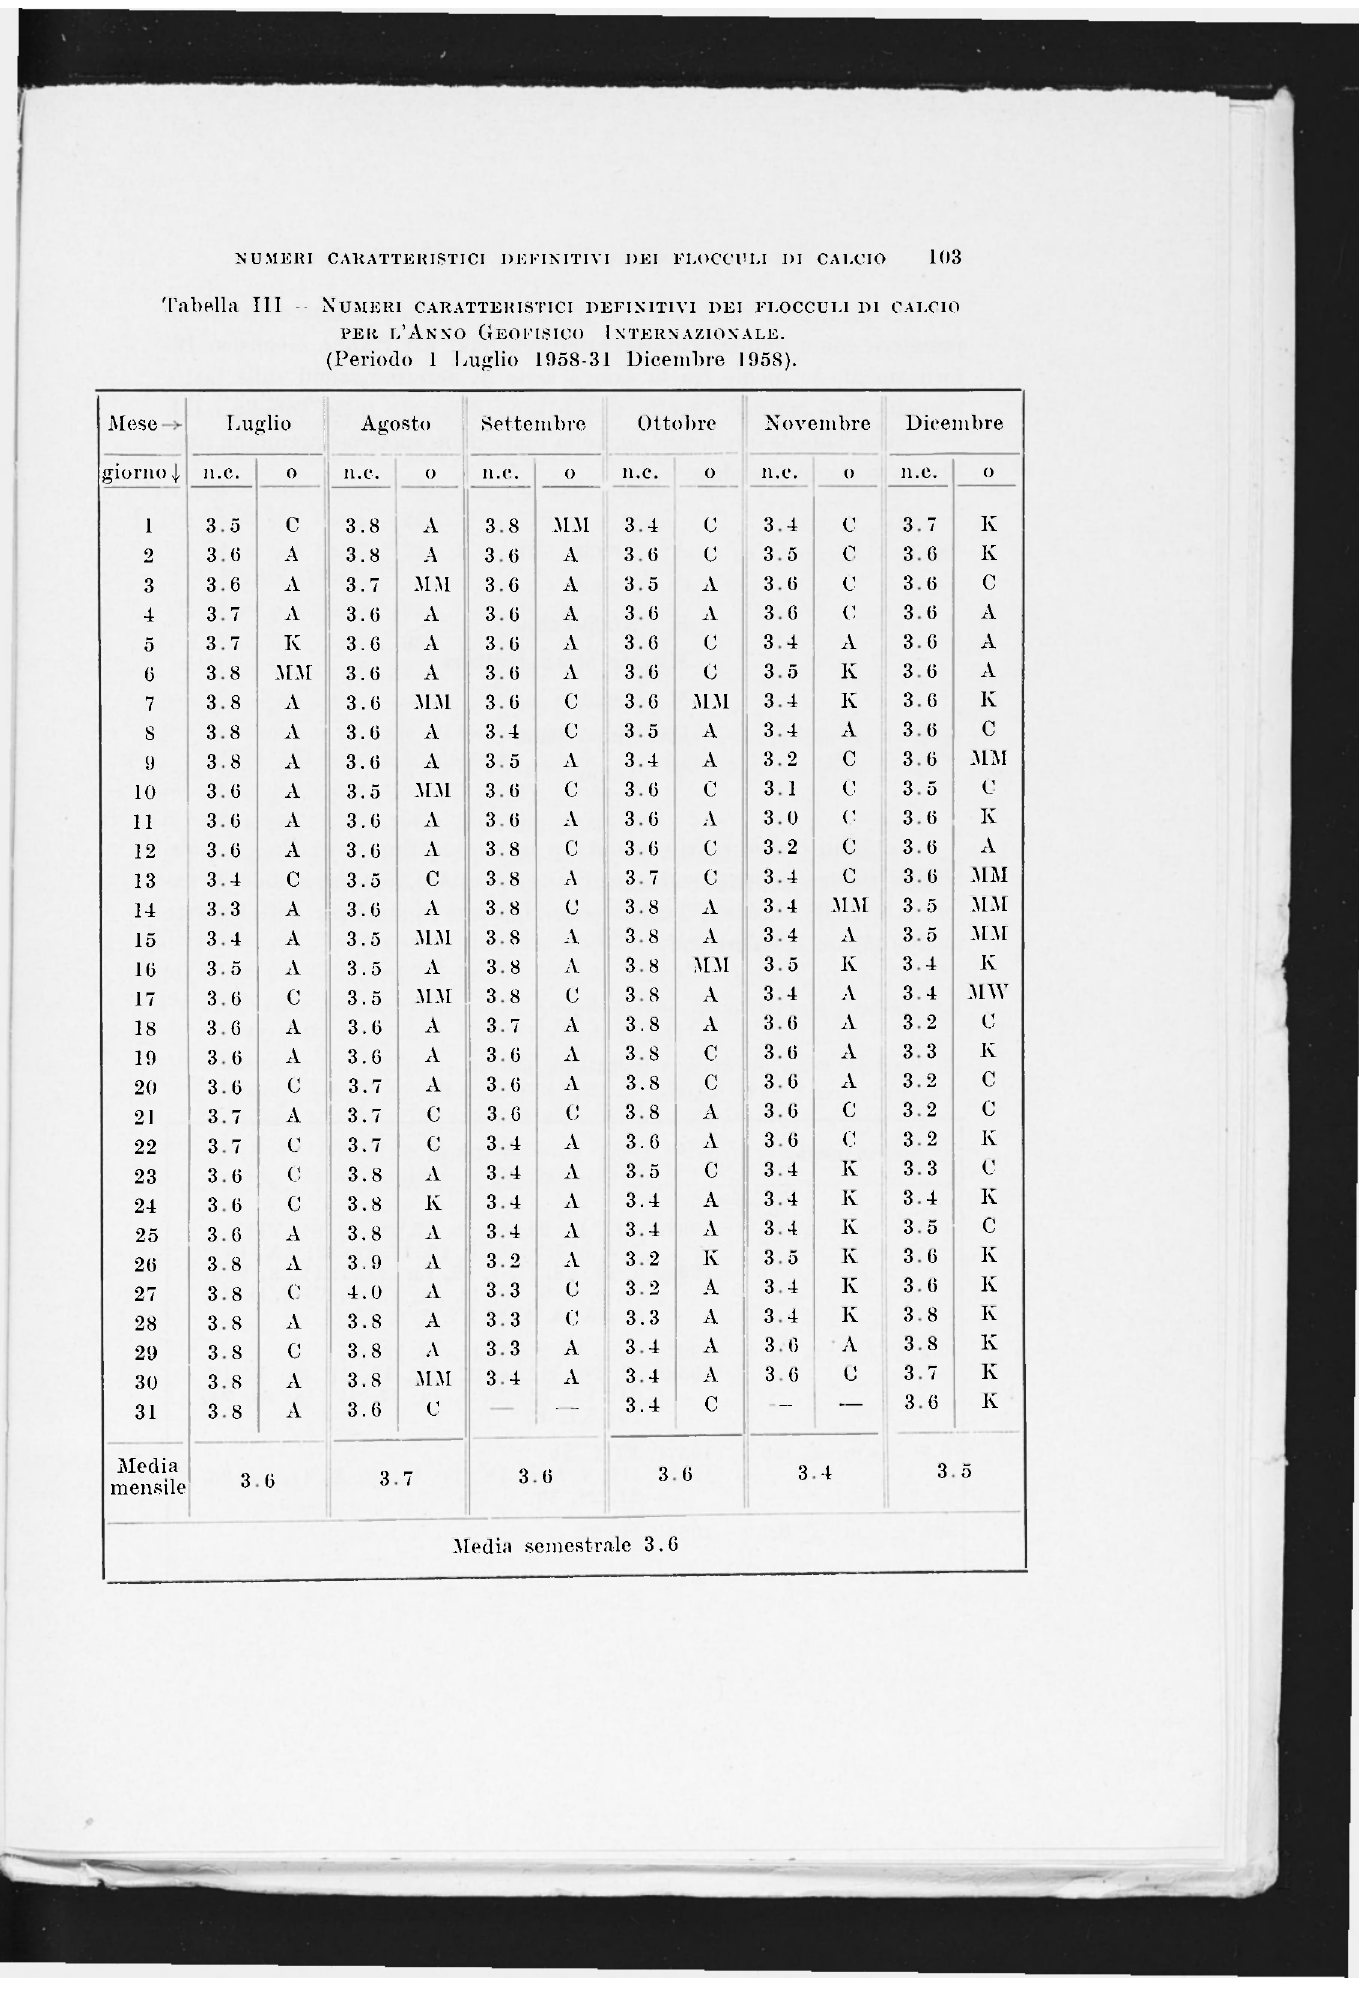
NUMERI CARATTERISTICI DEFINITIVI DEI FLOCCULI DI CALCIO PER L'ANNO GEOFÍSICO